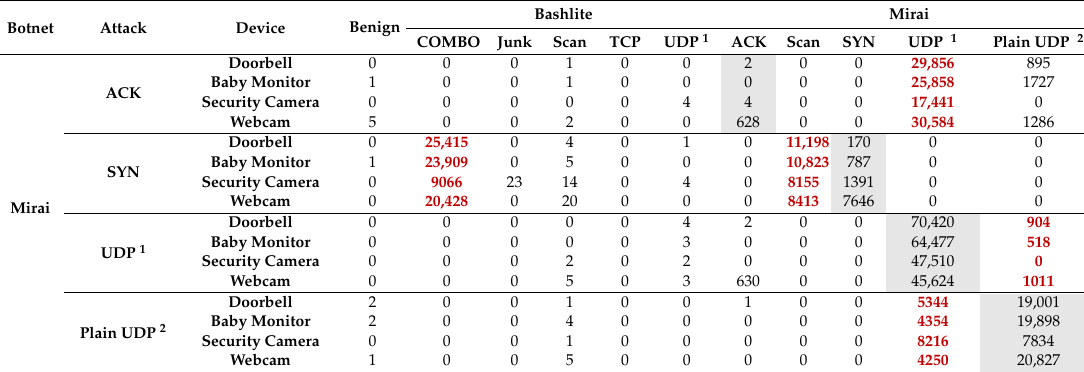
Table 13. Detailed results of the KNN-based botnet detection.